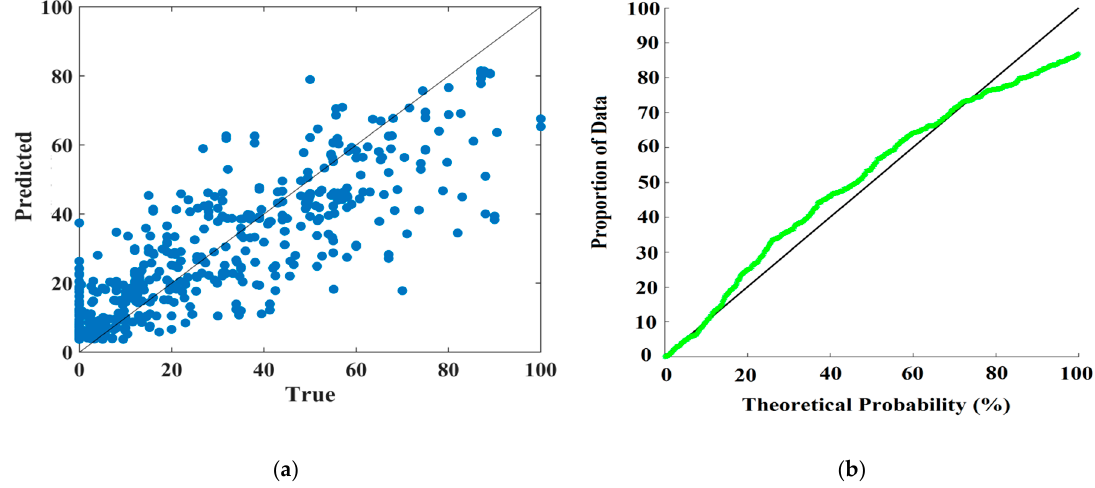
Figure 14. Validation of results. ( a ) Cross-validation for prediction vs. true values; black line: diagonal line (R = 87.58, MSE = 0.30); ( b ) Probabilities versus fractions of data that belong to probability intervals; solid line: identity; green line: accuracy plot.